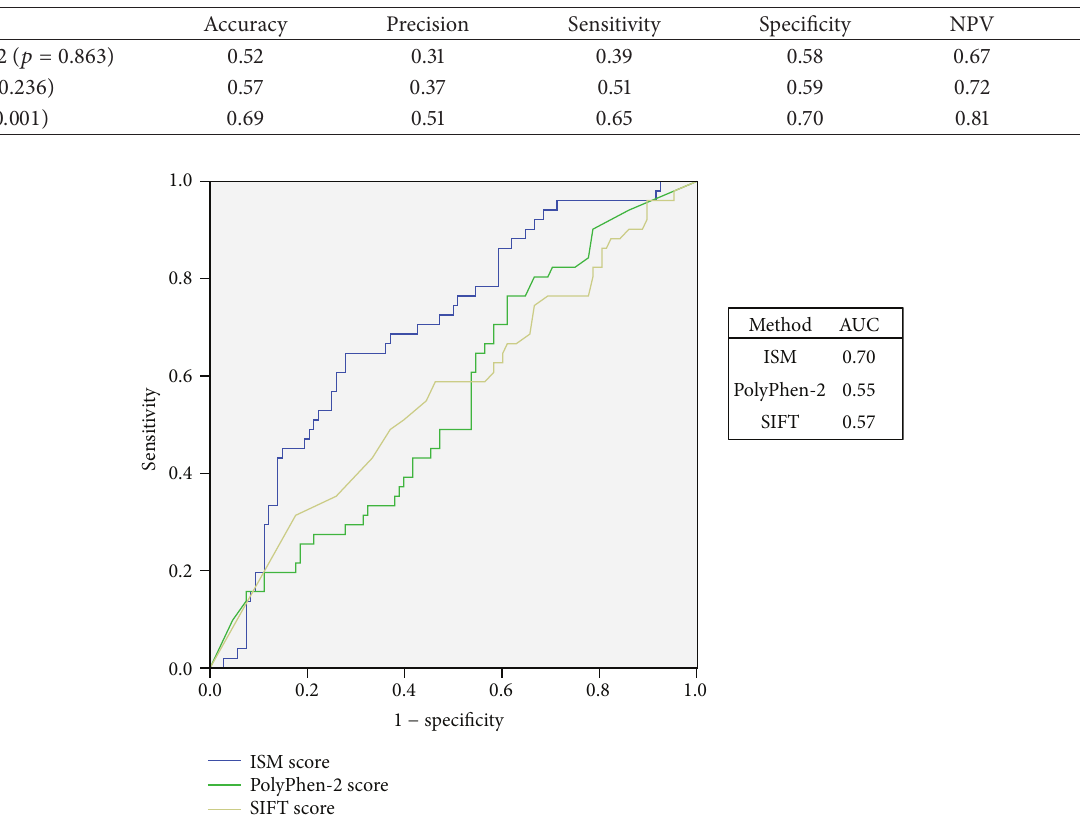
Figure 5: ROC curves on the ISM, PolyPhen-2 and SIFT scores for nCFD